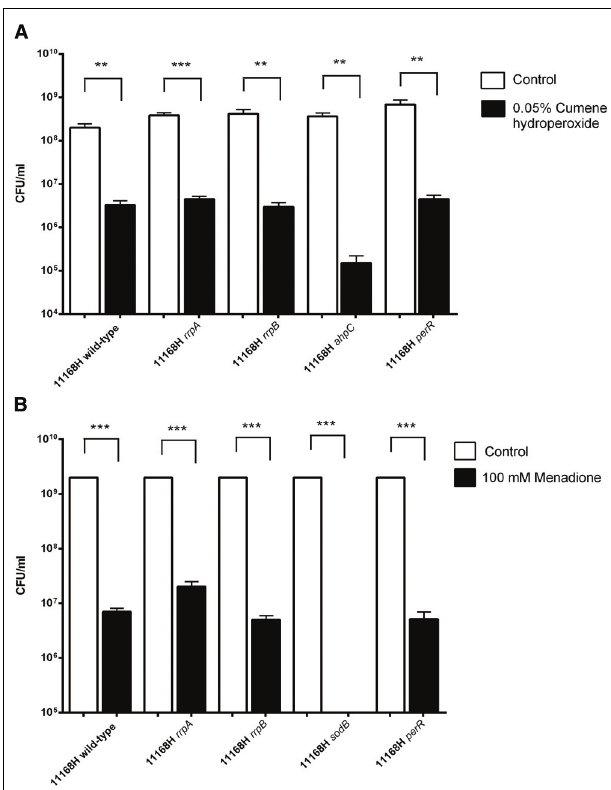
FIGURE 5 | Effect of (A) cumene hydroperoxide and (B) menadione on the survival of C. jejuni 11168H wild-type strain or mutants. Strains were exposed to 0.05% (w/v) cumene hydroperoxide for 15 min or 100 mM menadione for 1 h at 37°C under microaerobic conditions then bacterial survival assessed. Asterisks denote a statistically significant difference (** p < 0.01, *** p <